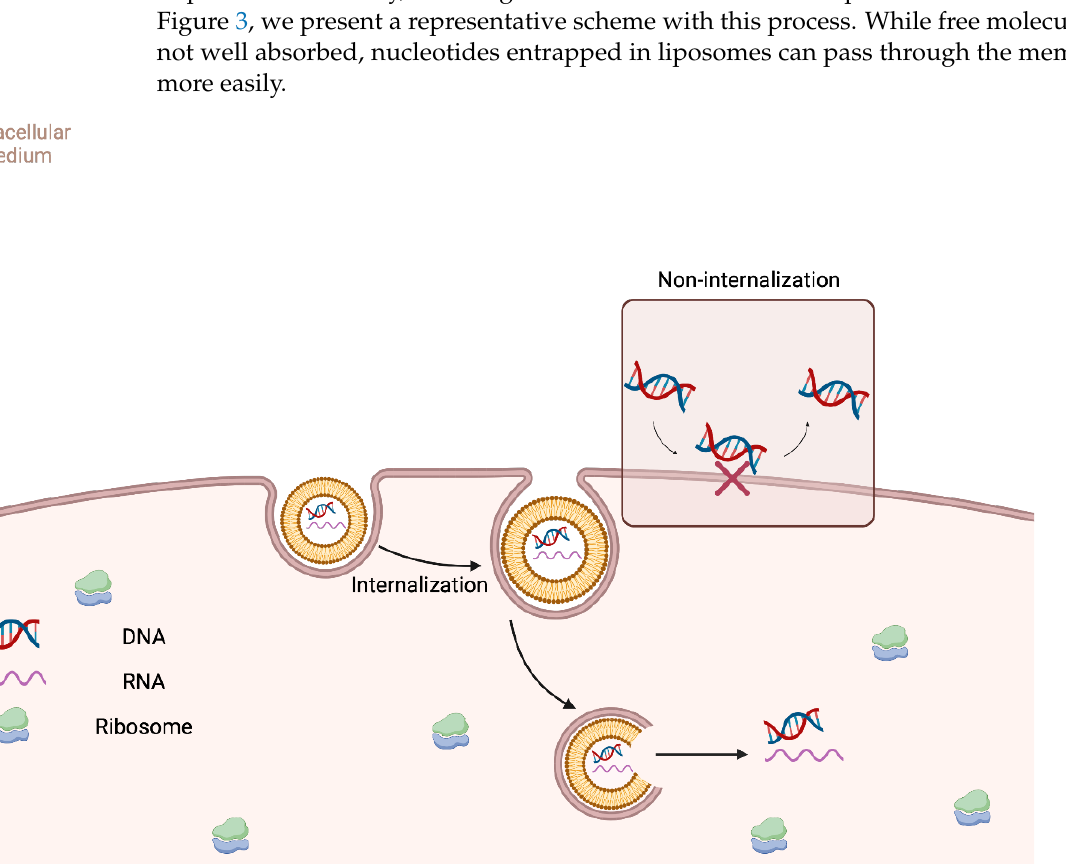
Figure 3. A representative scheme describing how the nucleotides entrapped in liposomes are internalized by cells. As hydrophilic acids, the transport of DNA/RNA molecules is not so easy. The association of the nucleotides with liposomes may improve this internalization process.